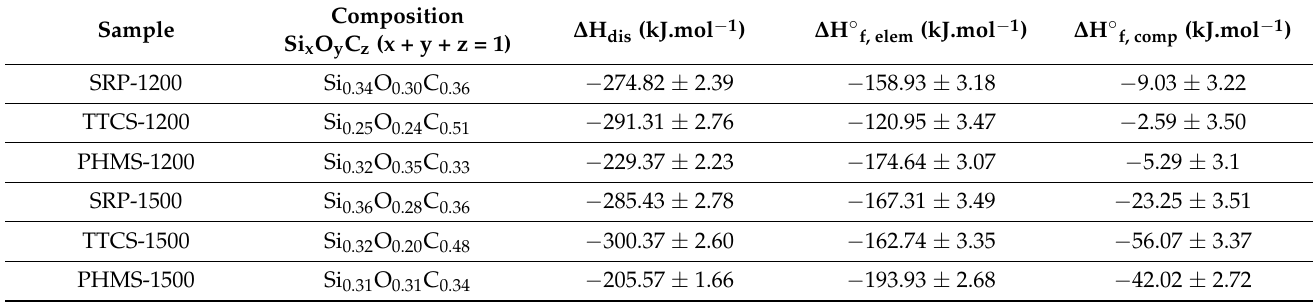
Table 5. Results for thermodynamic analysis using Si-corrected compositions from combustion analysis (ignoring low H